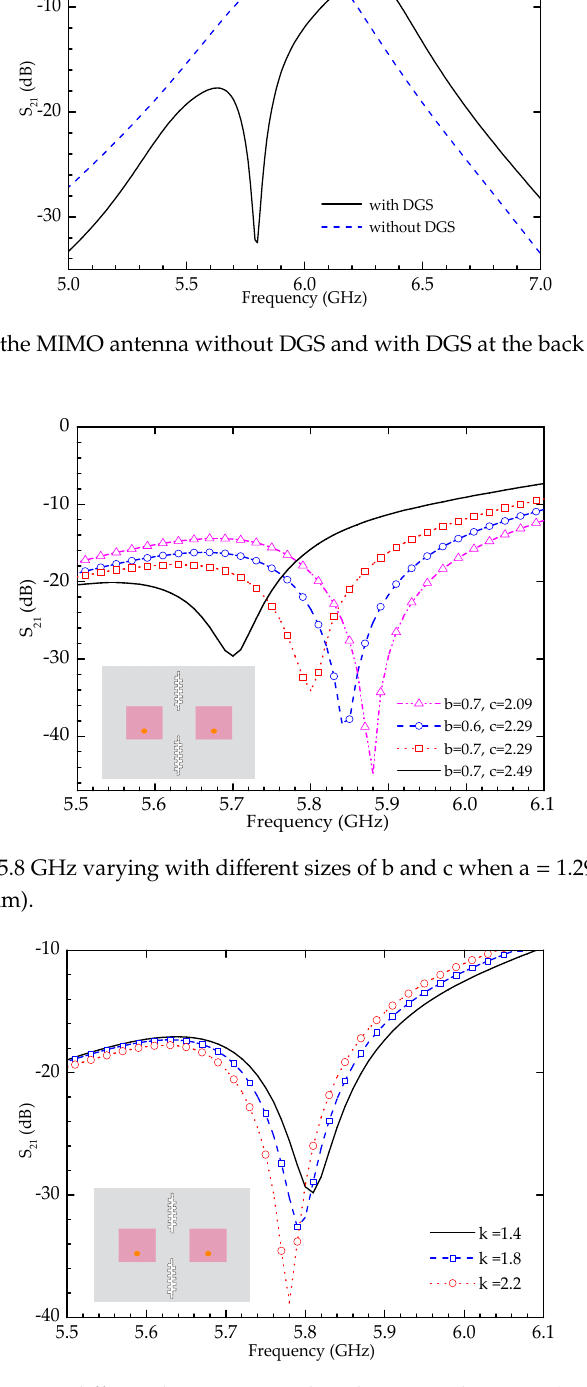
Figure 5. Isolation of the MIMO antenna without DGS and with DGS at the back plane side, focus on 5.8 GHz.